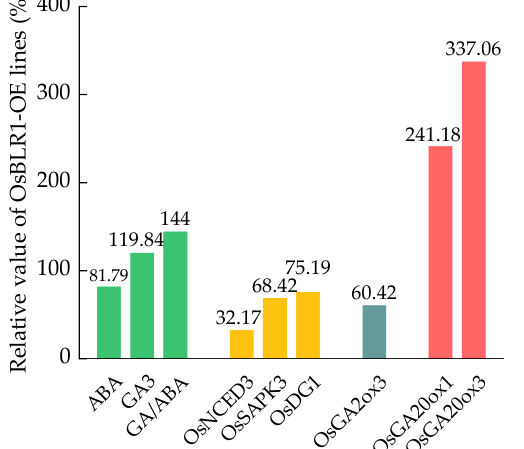
Figure 3. Relative values of GA 3 , ABA and GA/ABA and gene expression levels in OsBLR1-OE lines.